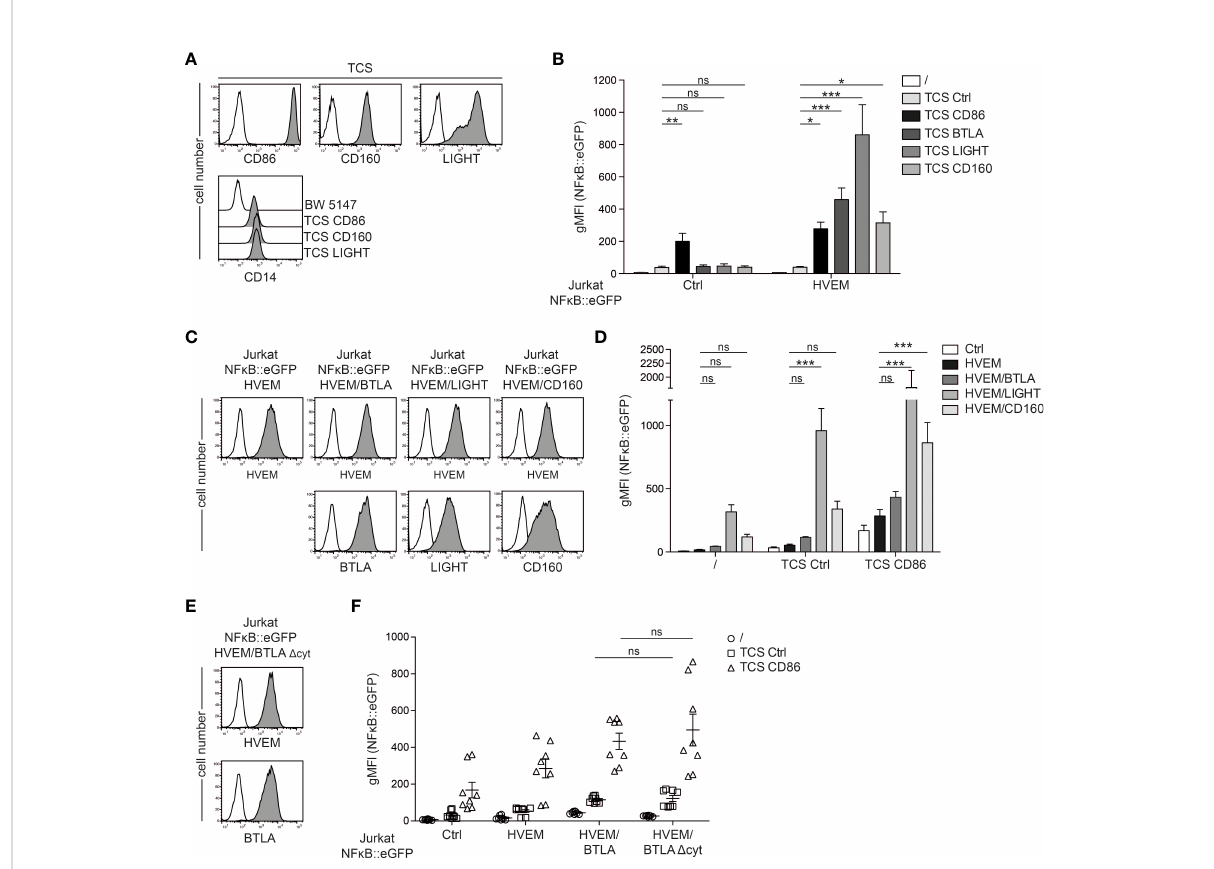
FIGURE 3 Regulation of HVEM co-stimulation in trans and in cis. (A) Upper panels: cell surface expression of CD86, CD160 and LIGHT on TCS analysed via fl ow cytometry (open histograms: control TCS; grey histograms: TCS expressing the indicated molecules). Lower panel: membrane-bound anti-CD3-fragment (detected via its CD14 stem) on TCS analysed via fl ow cytometry. Parental BW5147 cells were used as a control. (B) Control reporter cells and HVEM expressing reporter cells were stimulated with control TCS and TCS expressing CD86, BTLA, LIGHT and CD160 for 24 h and NF k B::eGFP expression was measured by fl ow cytometry. Data is shown from 4 independent experiments performed in duplicates. For statistical evaluation, one-way ANOVA with Dunn ’ s multiple-comparisons test was performed (***p ≤ 0.001; **p ≤ 0.01; *p < 0.05; ns, p >